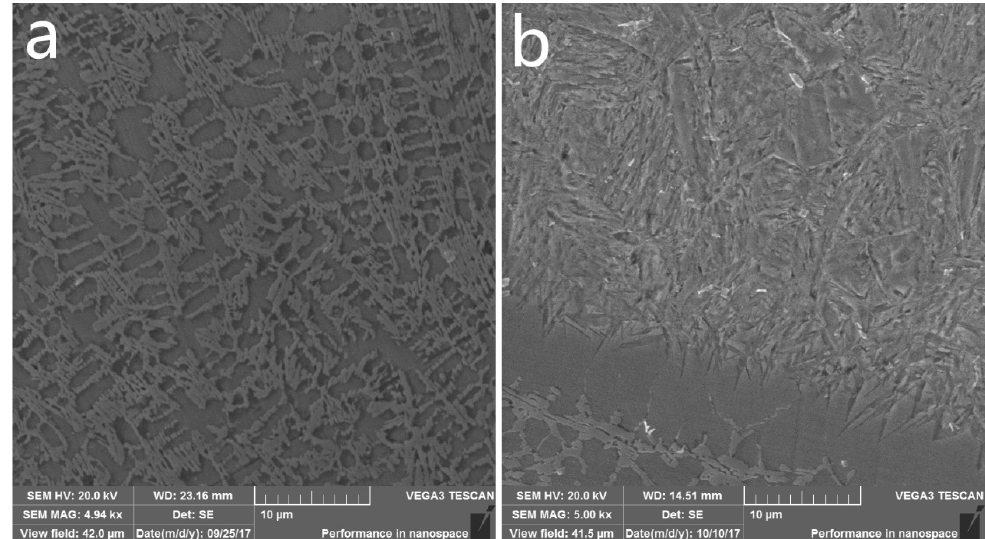
Figure 5. Section microstructure of a biomimetic unit.